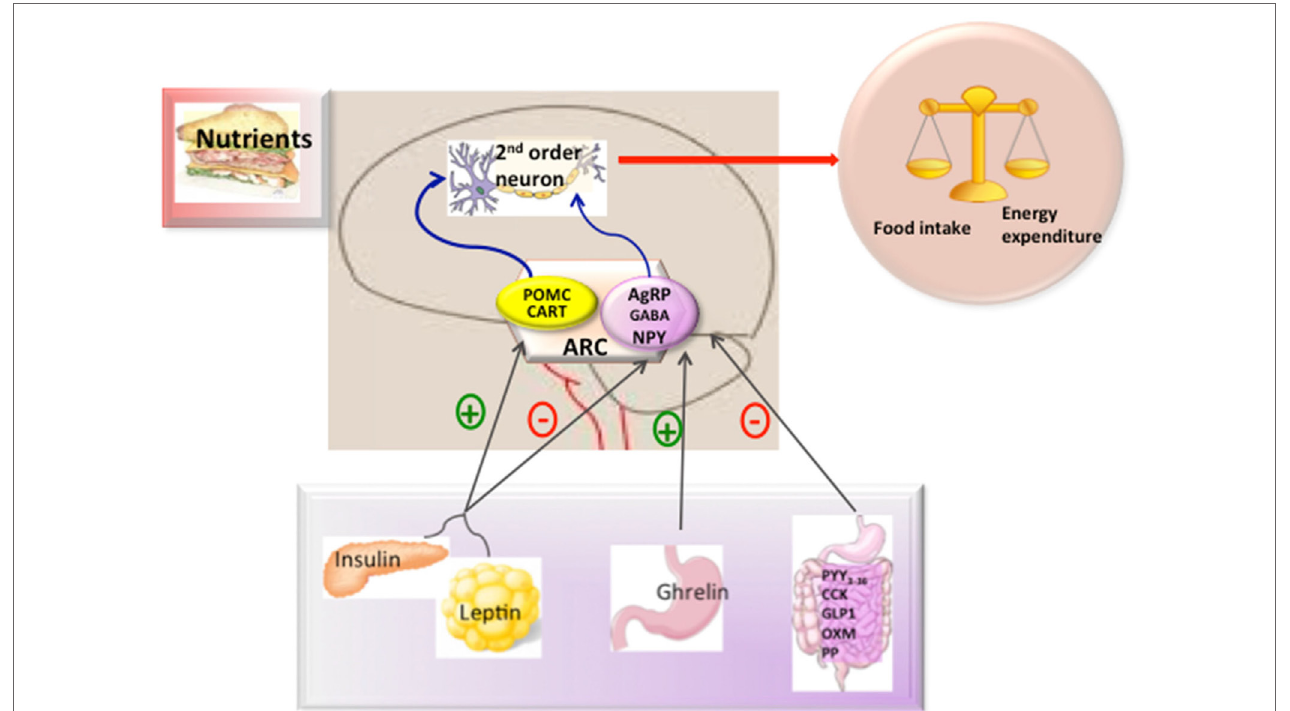
FigURe 1 | Hypothalamic control of energy metabolism. The brain integrates metabolic signals (leptin, insulin, ghrelin, PYY 3–36 ) from peripheral tissues such as pancreas, adipose tissue, and gut. In the brain, specialized neuronal networks coordinate adaptive changes in food intake and energy expenditure. Neuropeptide Y/ agouti-related protein (AgRP)-gamma aminobutyric acid (GABA) and proopiomelanocortin (POMC)-Cocaine and amphetamine-related transcript (CART) producing neurons in the hypothalamic arcuate nucleus primarily sense the body energy state. These neurons project to other second order neurons to control the regulation of energy balance. Abbreviations: ARC, arcuate nucleus; PYY3-36, peptide YY3-36; CK, cholecystokinin; GLP-1, glucagon-like peptide-1; OXM, oxyntomoduline; PP, pancreatic polypeptide.